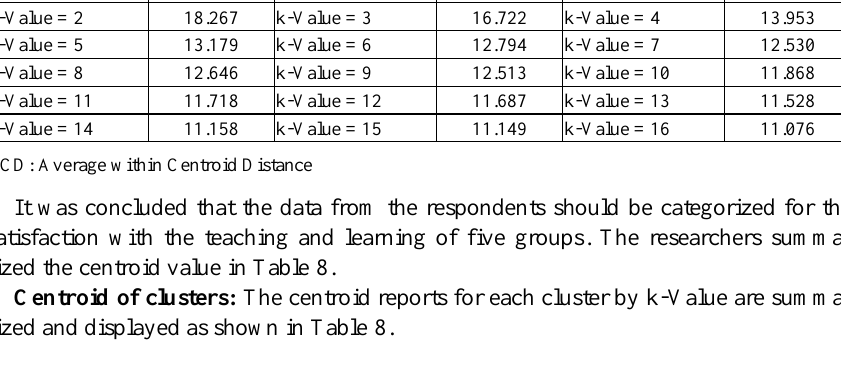
Table 8. Summary of centroid values in each